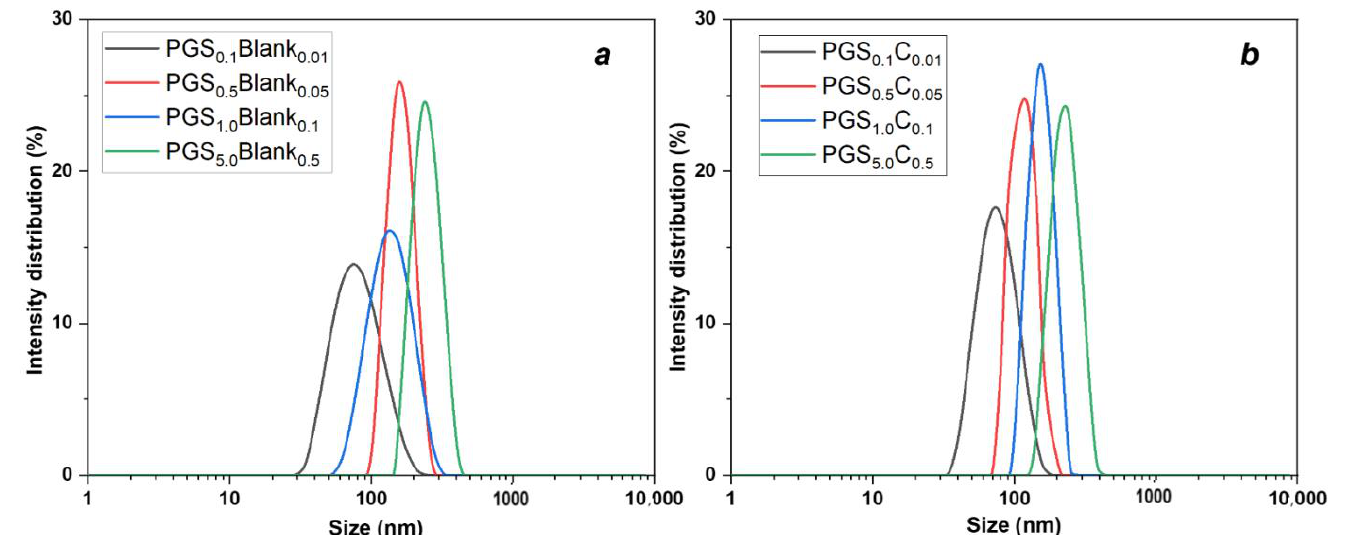
Figure 2. DLS size distribution (intensity) of unloaded ( a ) and curcumin-loaded PGS-NPs ( b ) formed at different polymer concentrations (0.1, 0.5, 1.0 and 5.0 mg/mL). Table 1. Effect of polymer concentration on PGS-NPs particle diameter at t = 0, after 7 days and after 14 days from sample preparation.